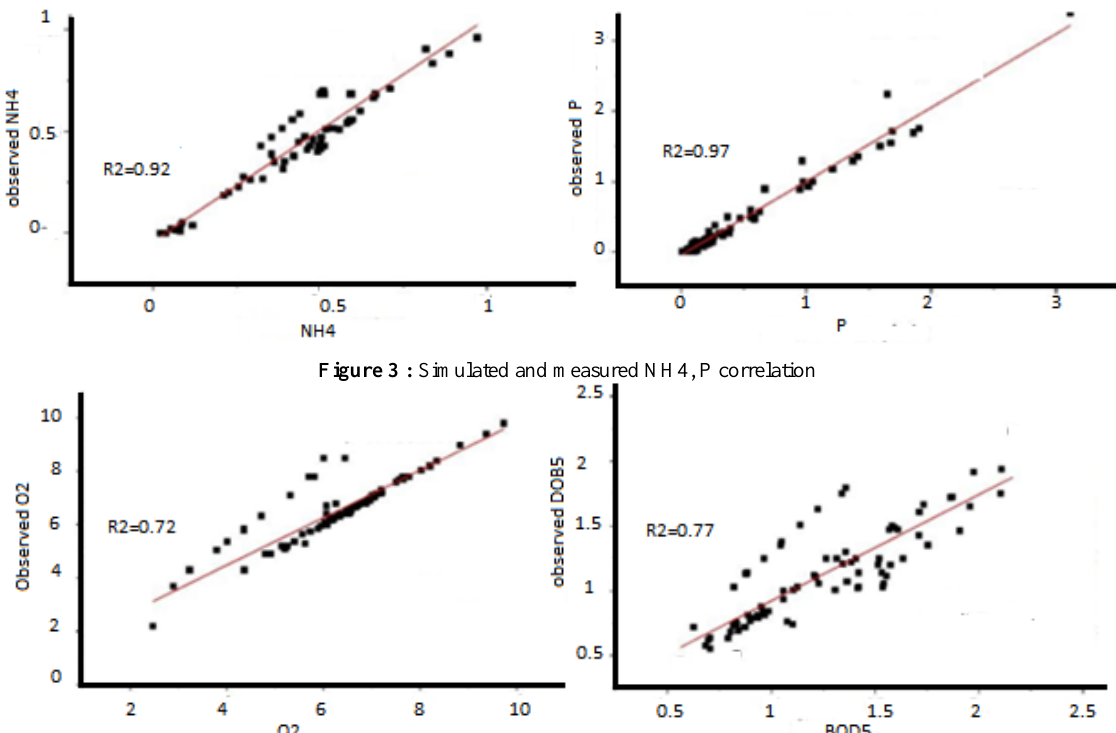
Figure 4: Simulated and measured O 2 , BDO